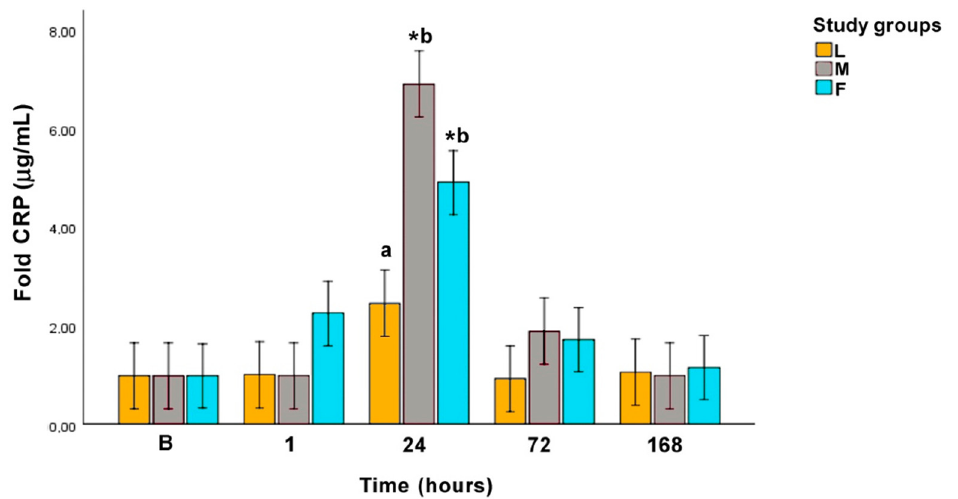
Figure 2. Fold C-reactive protein (CRP) concentration along the experimental period. L: laparoscopic ovariectomy (OVE), M: midline OVE, and F: flank OVE. Different letters (a, b) indicate differences between groups. B: baseline. * p < 0.05: statistically significant difference compared to baseline.